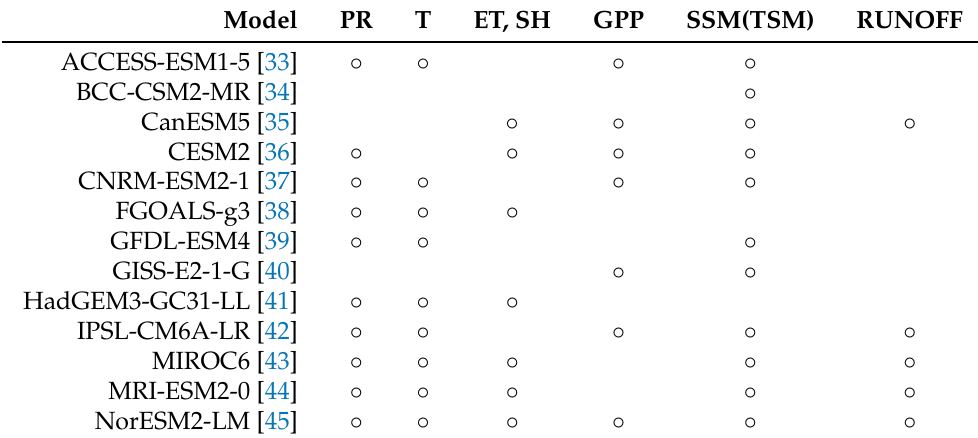
Table 2. CMIP6 DAMIP model list used in this study where PR is precipitation, T is 2 m air temperature, ET is evapotranspiration, SH is sensible heat flux, SSM and TSM are surface and total soil moisture, and RUNOFF is